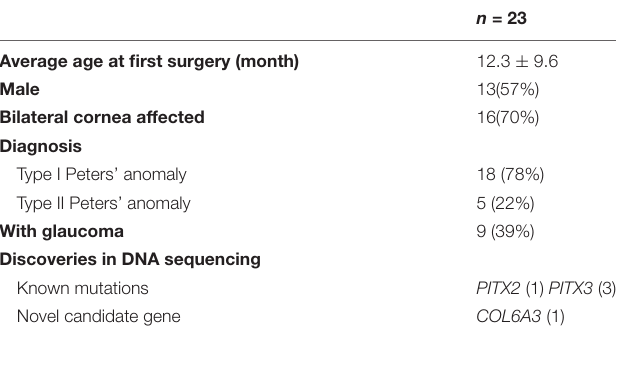
TABLE 1 | Summary of clinical characteristics of recruited